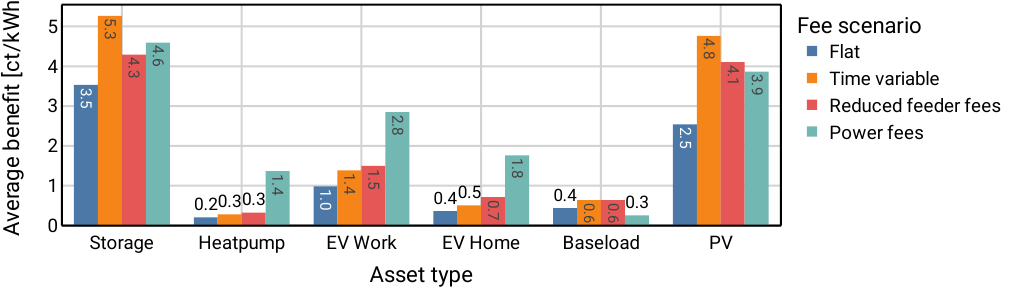
Figure 12. Average asset-specific benefit compared to the business-as-usual scenario for a variation of grid tariff designs/fee scenarios, the semiurban grid and the scenario year 2035.